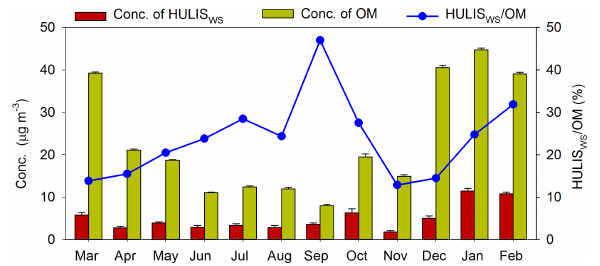
Figure 2. Temporal variation of HULIS WS mass concentration and extrinsic DTT activity of HULIS WS in